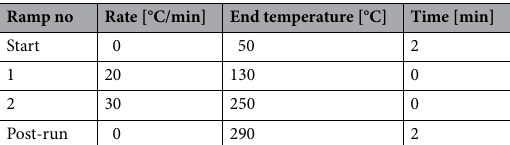
Table 1. Temperature program of the gas chromatograph.